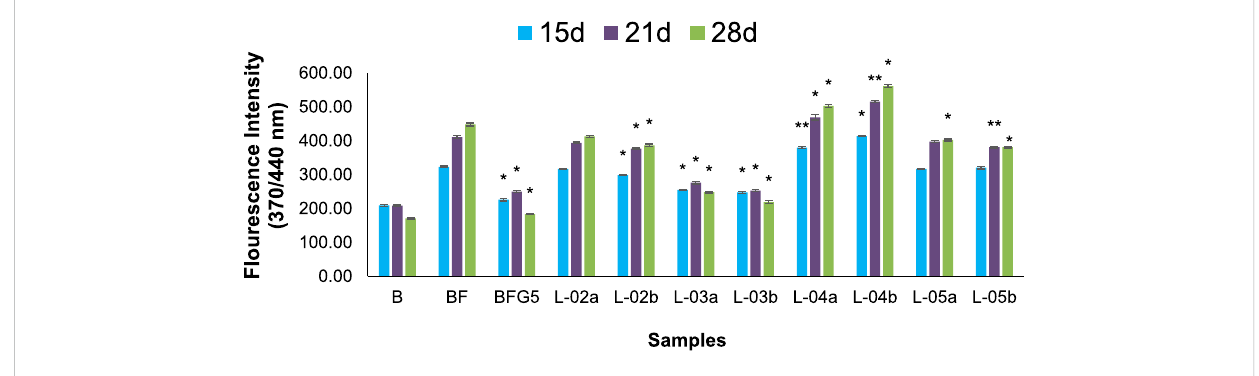
FIGURE 6 Effect of different solvent fractions of L. ovalifolia on the formation of fl uorescent AGEs in BSA incubated with fructose. p * < 0.01, p ** < 0.05, p *** < 0.001 relativeto control i.e., comparedto BSA/Fructose(BF) on sameduration (L-02a,L-03a, L-04a, L-05a at50 μ g/mL and L-02b, L-03b,L-04b, L-05b at 100 μ g/mL concentration); d: